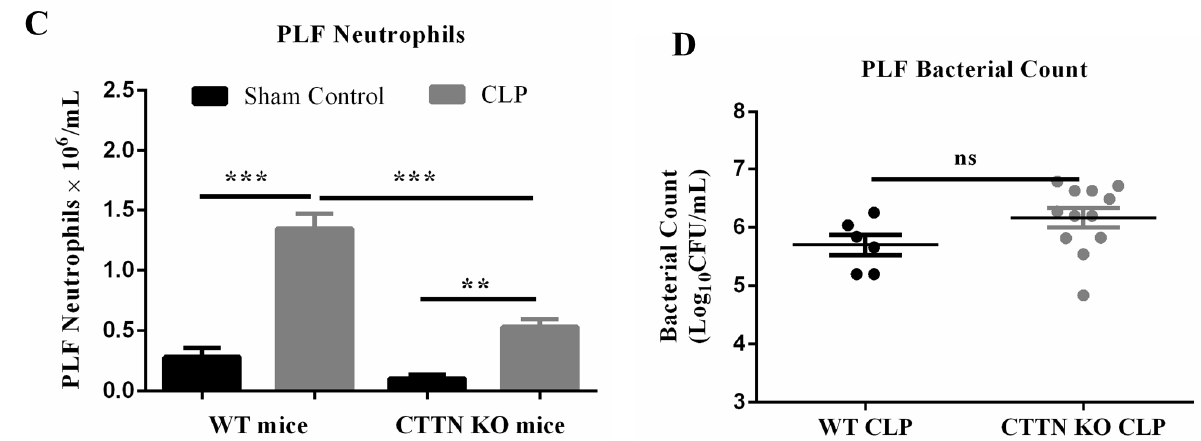
Figure 6. Cortactin deficiency prevents the excessive influx of PMN into the peritoneum without affecting bacteria count. Total numbers of peritoneal cells were counted using a Neubauer chamber ( A ). The numbers of CD45+ total leukocytes ( B ) and CD45+ LY6G+ neutrophils ( C ) in the peritoneal cavity 24 h after CLP sepsis were determined by flow cytometry. ( D ) Bacterial counts were determined by inoculating serially diluted peritoneal lavage fluid (PLF) on tryptic soy agar plate and counting colony-forming units after 24 h incubation at 37 °C; dots represent the number of colony-forming units of PLF from independent mice. Data are represented as mean ± SEM of at least 5 animals per group. * p < 0.05, ** p < 0.01, *** p < 0.001. ns: non-significant.